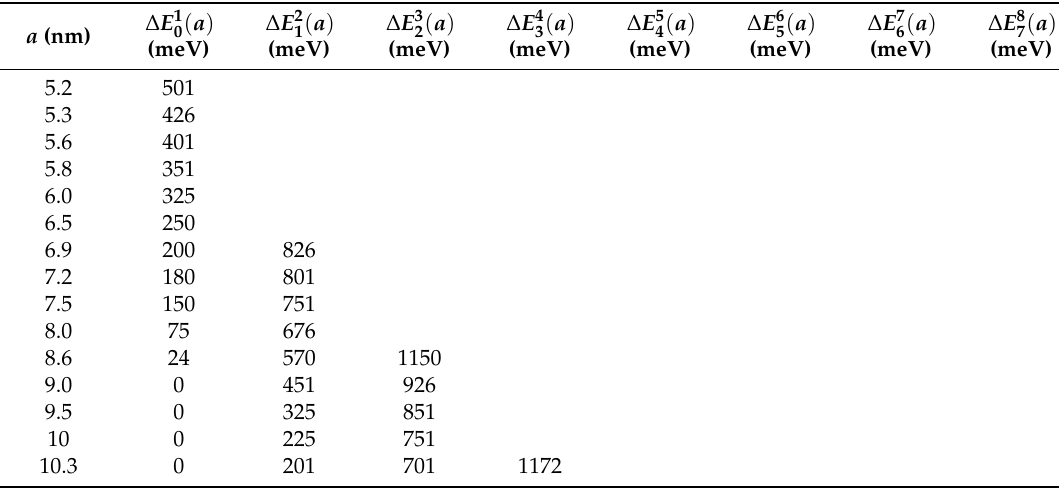
( a ) (expressed by meV), in which the orbital quantum number l Table 1. Energy transitions ∆ E l l − 1 changes by one (wherein l takes values from 1 to 8) between quasi-stationary and stationary states of the exciton (from the spatially separated electrons and holes) (see Figure 1), appearing in the nannosystem containing aluminum oxide QD with a radius (expressed by nm), situated in the dielectric matrix (vacuum